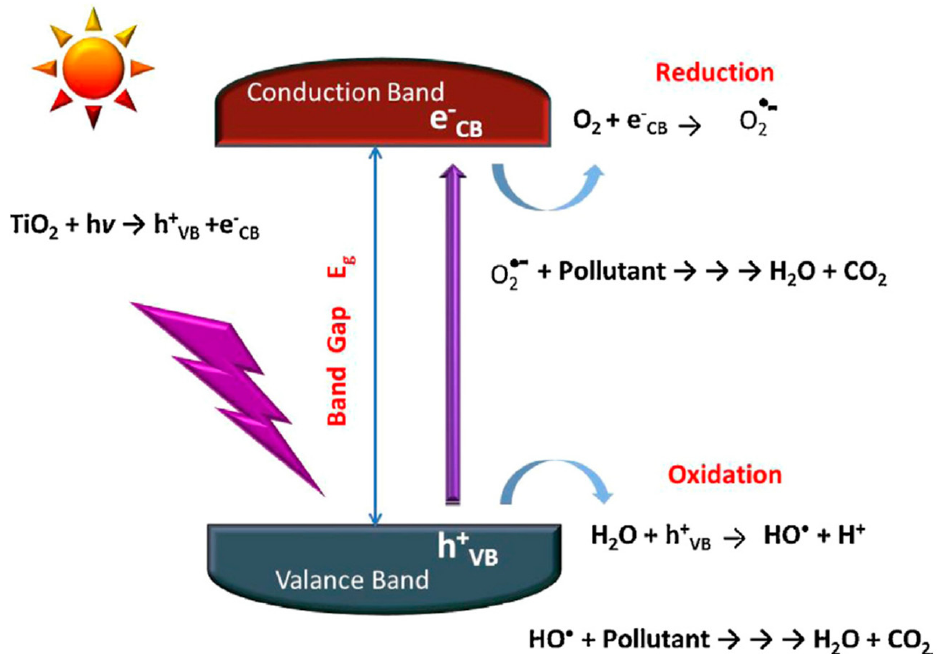
Figure 4. Indicative mechanism of photocatalysis on TiO 2 (adapted from [78]).